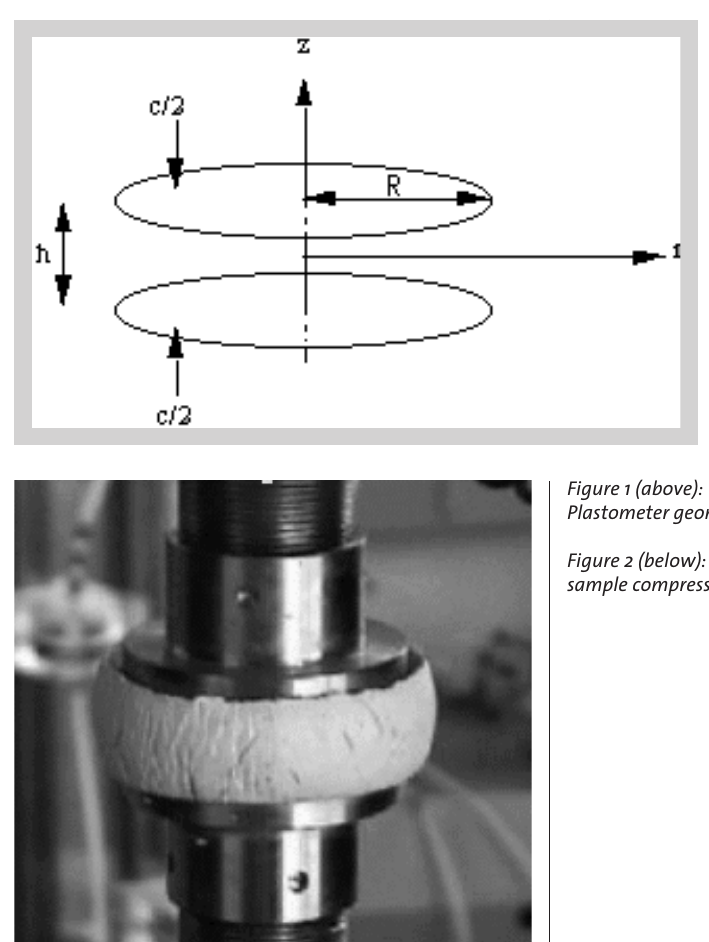
Figure 1 (above): Plastometer geometry. Figure 2 (below): Kaolin clay sample